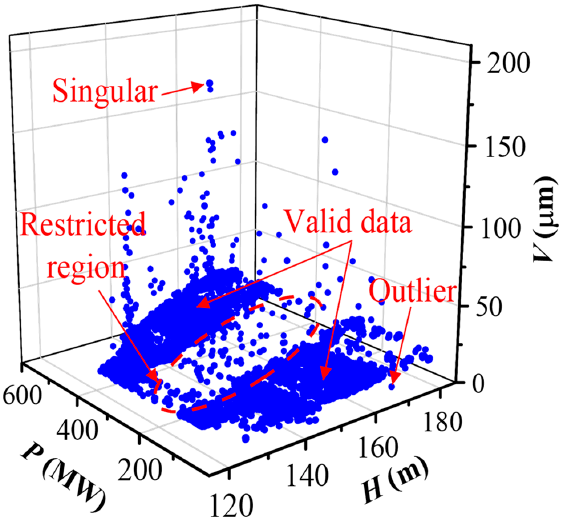
Figure 9. The three-dimensional sample set. Figure 9. The three ‐ dimensional sample set.